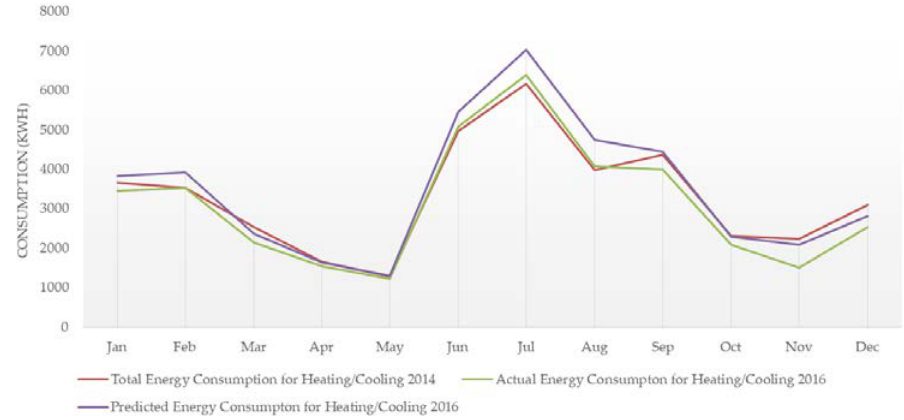
Figure 7. Energy consumption data (2014 and 2016)—2nd year of operation.